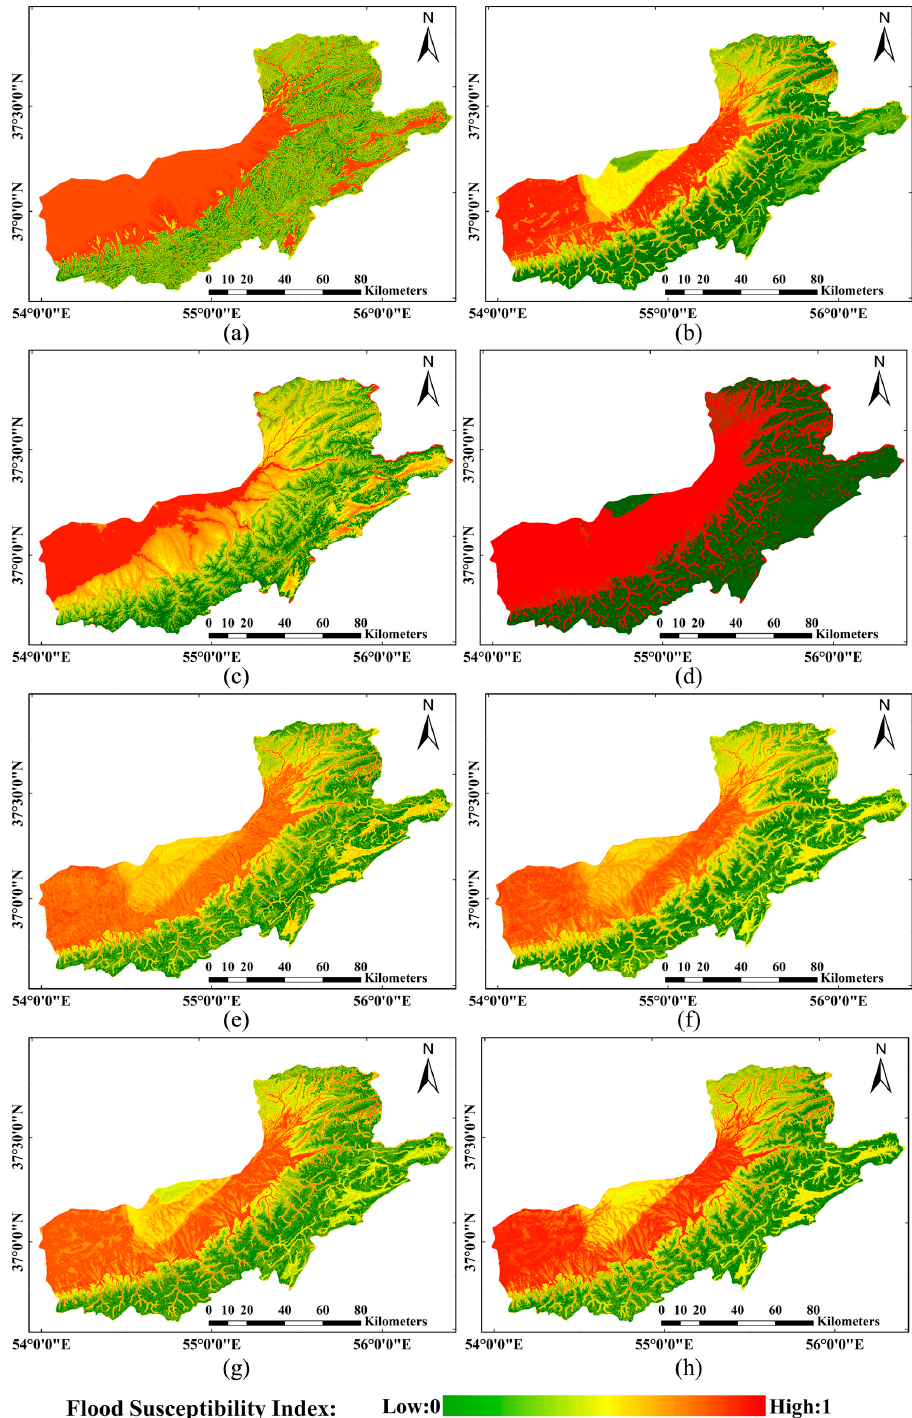
Figure 11. The FSM maps derived from different models for the Gorganrud basin: ( a ) Support Vector Machine (SVM), ( b ) Random Forest (RF), ( c ) Deep Neural Network (DNN), ( d ) Decision Tree (DT), ( e ) Light Gradient Boosting Machine (LightGBM), ( f ) Categorical Boosting (CatBoost), ( g ) Extreme Gradient Boosting (XGBoost), and ( h ) Cascade Forest Model (CFM).